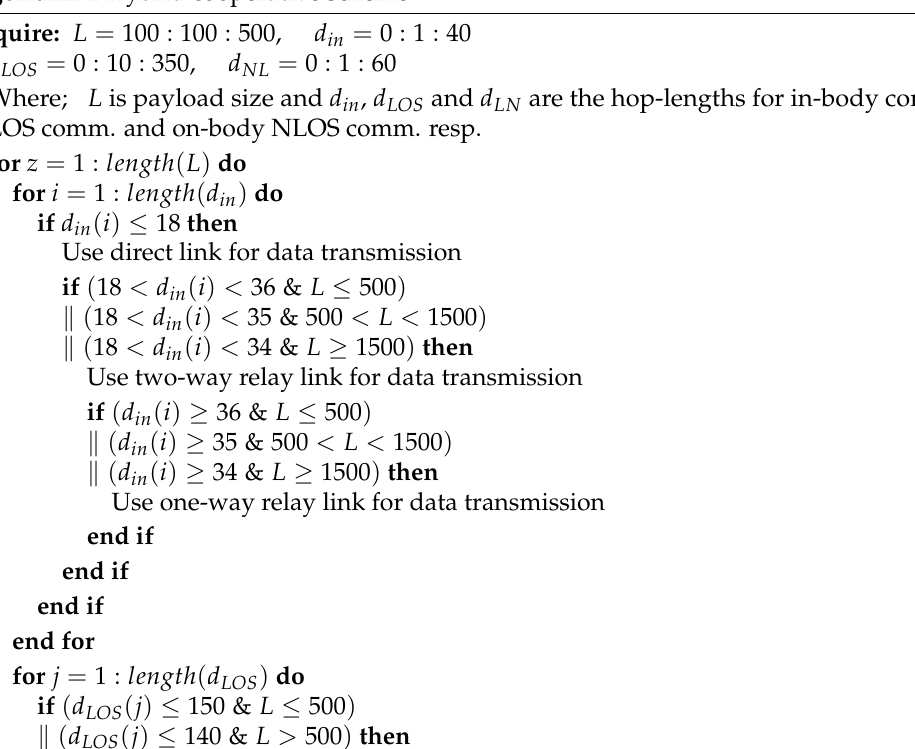
Algorithm 1 Hybrid cooperative